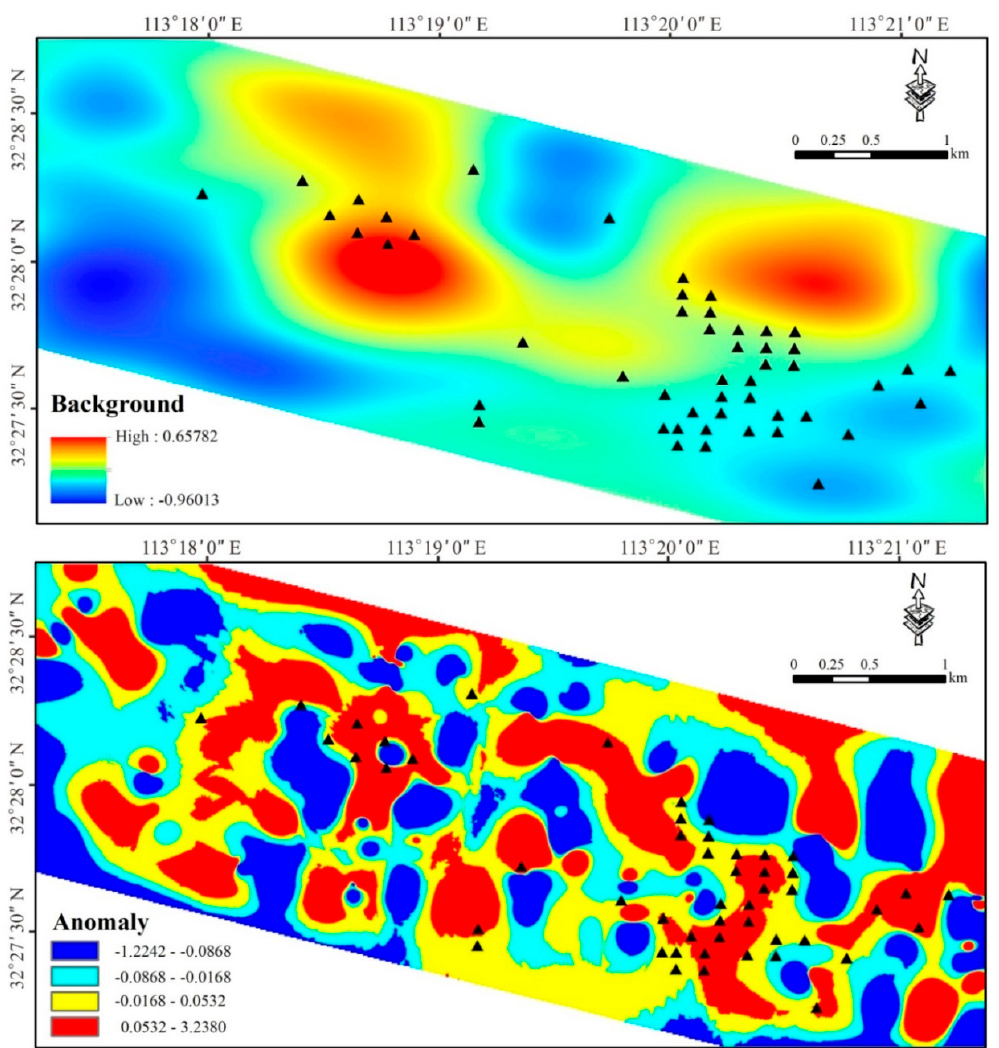
Figure 10. The decomposed map of major ore-forming elements (F2: Au–Ag–Cu–As–Sb–S) for background and anomaly (black triangle presenting drillings with ore encountered.